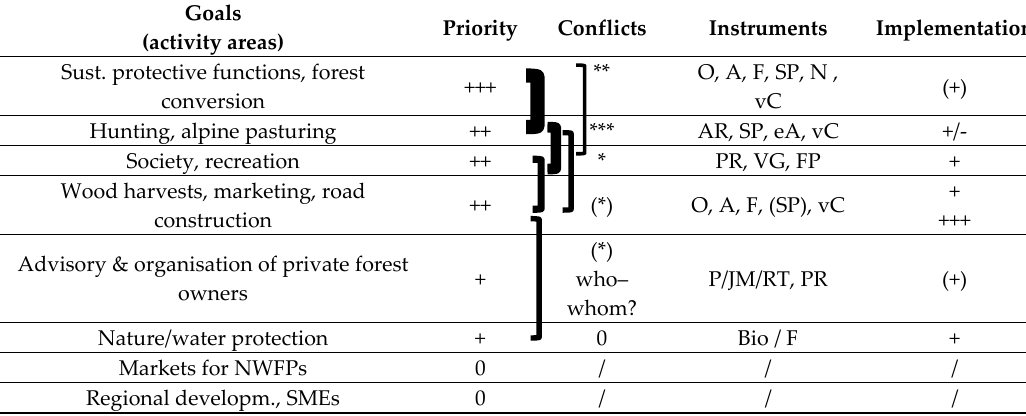
Table 1. Comparing goal priority, conflicts, applied instruments and implementation success, across GFI goals.